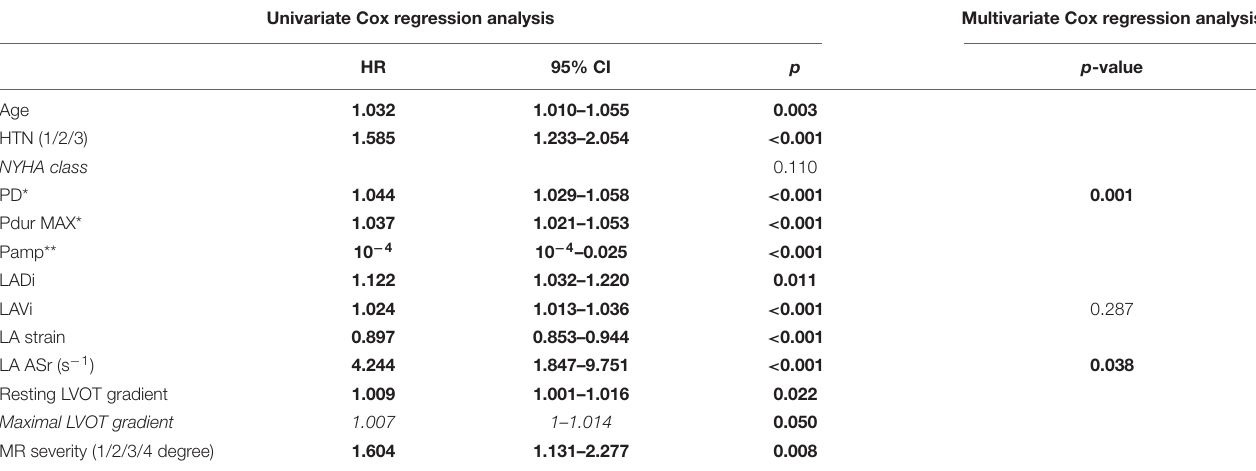
TABLE 2 | Independent predictors for incident AF in the whole HCM population.